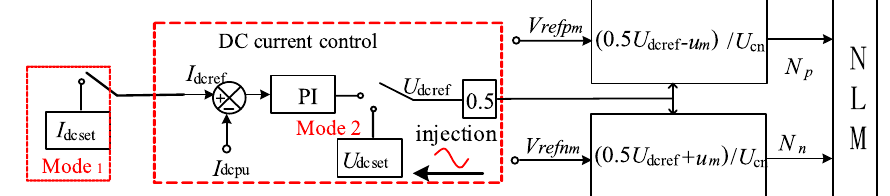
Fig. 5 Additional control block